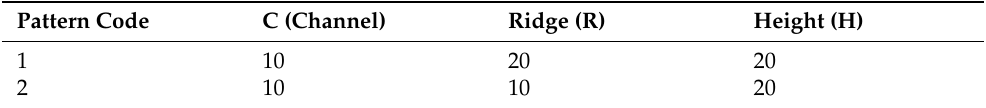
Table 2. Expected pattern dimensions (in µ m) of the constructs.